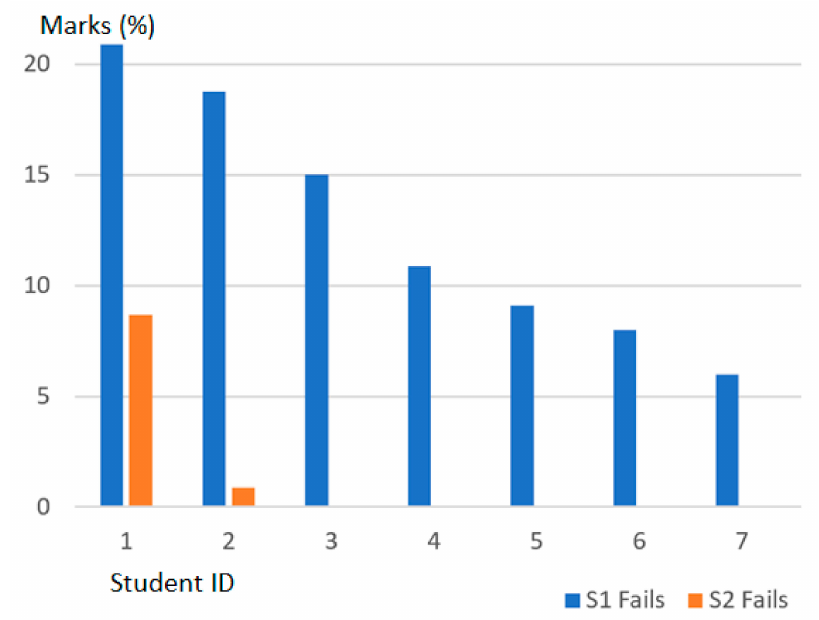
Figure 7. Comparison of student dropouts (S1and